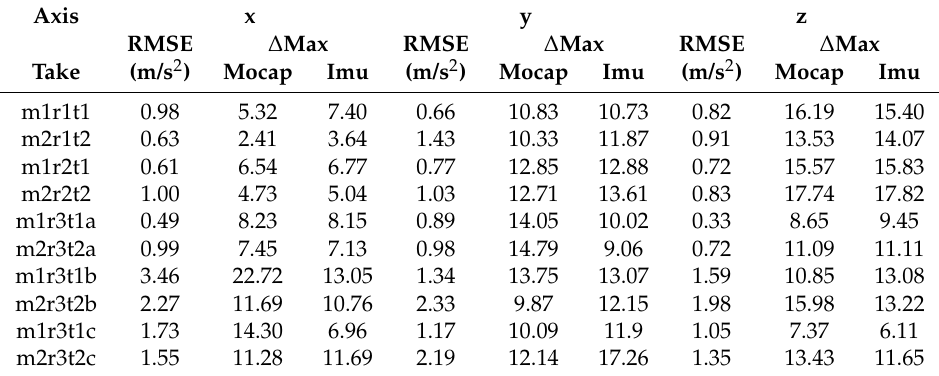
Table 4. RMSE and maximal ranges (per axis) in the comparison of acceleration data of both systems—selected takes from musicians 1 and 2. Axis